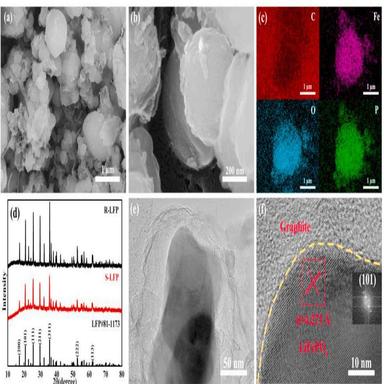
(a, b) SEM images and (c) elemental mapping for R-LFP, (d) The XRD patterns for S-LFP and R-LFP, (e, f) TEM and HRTEM images for R-LFP.